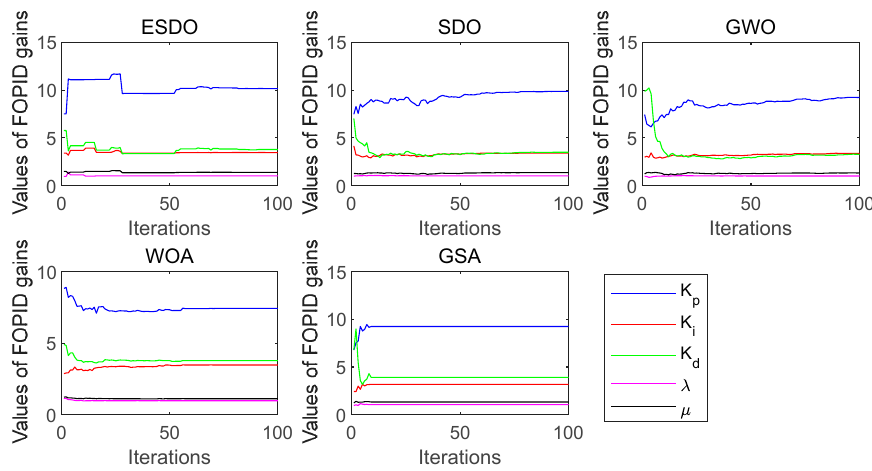
Figure 19. Convergence curves of FOPID parameters with 16% load.